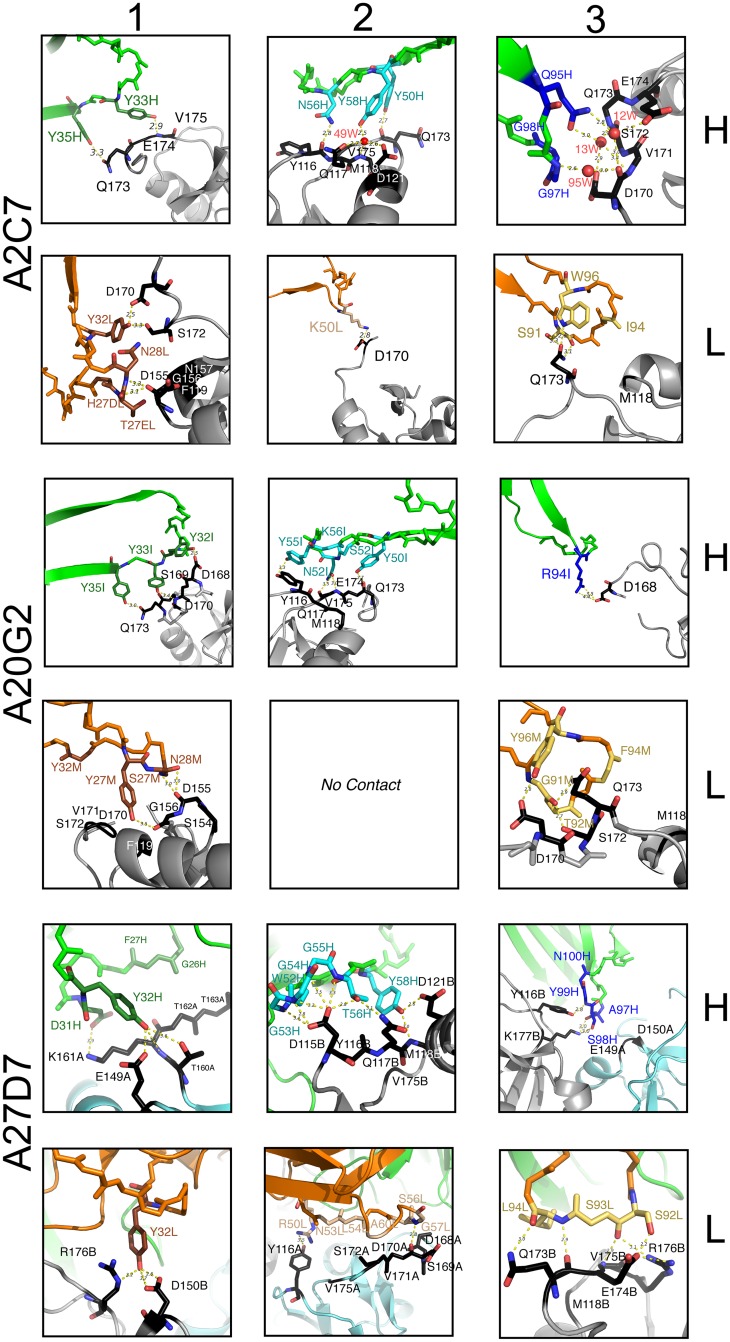
Detailed contacts at the Ag:Fab interface.Interactions between A33 residues and light-chain (L, orange) or heavy chain (H, green) CDRs (1–3) of the MAbs A2C7, A20G2, and A27D7. Residues that elicit actual contacts as defined in S3 Table are colored according to Fig 4. Main chain is shown uniformly for residues eliciting VdW interactions, while individual atoms are colored for residues eliciting electrostatic interactions. Amino acid side chains are shown when relevant. A33 backbone in grey, and contact residues in black. Only main chain atoms are shown when residues are involved in VdW interactions.